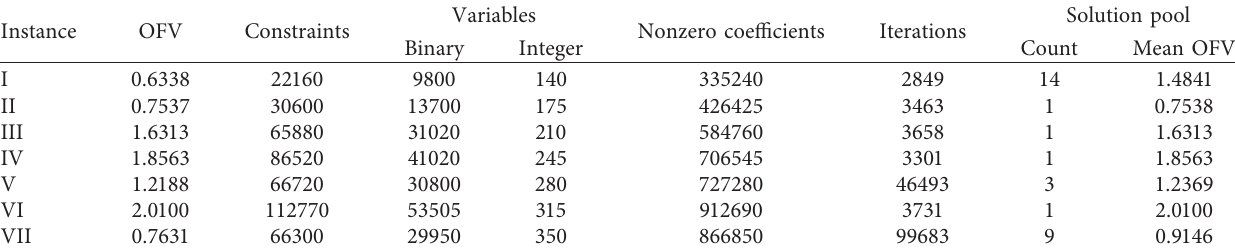
Table 4: The solving statistical information with BYCA-TSIS for the first stage by CPLEX.